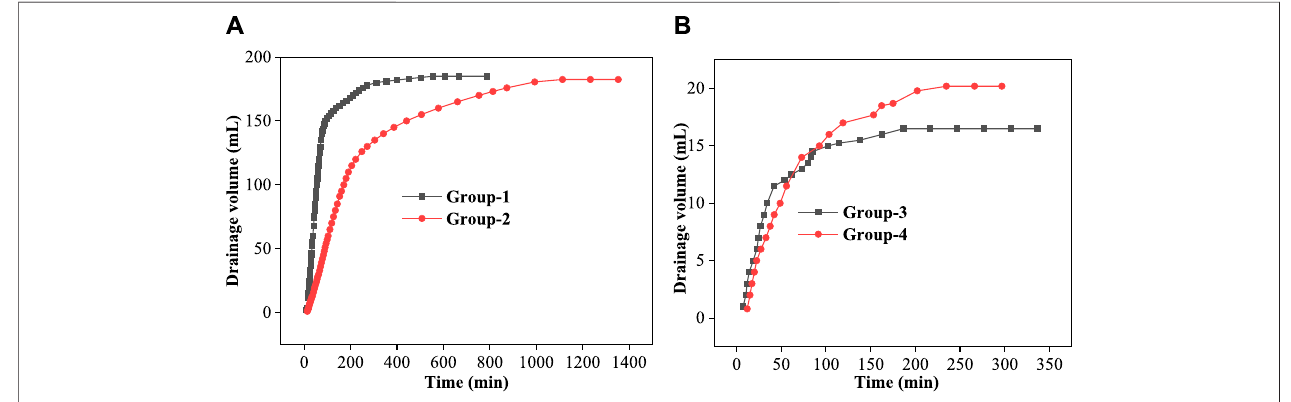
FIGURE 8 | Drainage volume varies with time: (A) dolomite reactions; (B) core reactions.